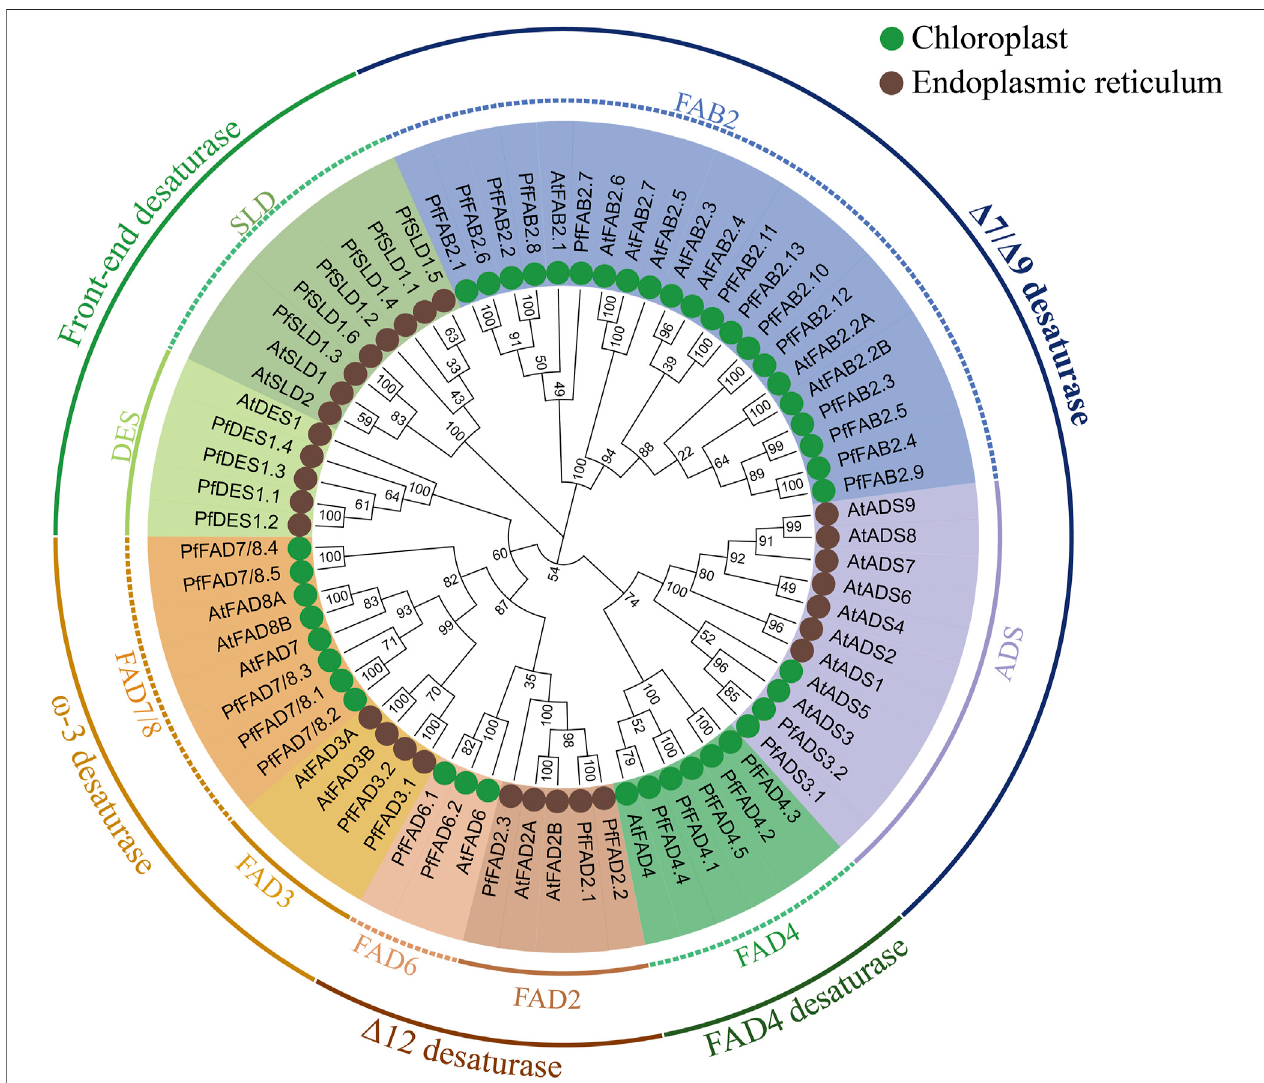
FIGURE 1 | Phylogenetic relationships of FAD genes from perilla and Arabidopsis . The tree was constructed using MEGA X by the neighbor-joining method with 1,000 bootstraps. Subcellular localizations were predicted using ExPASy combined with Cell-PLoc.